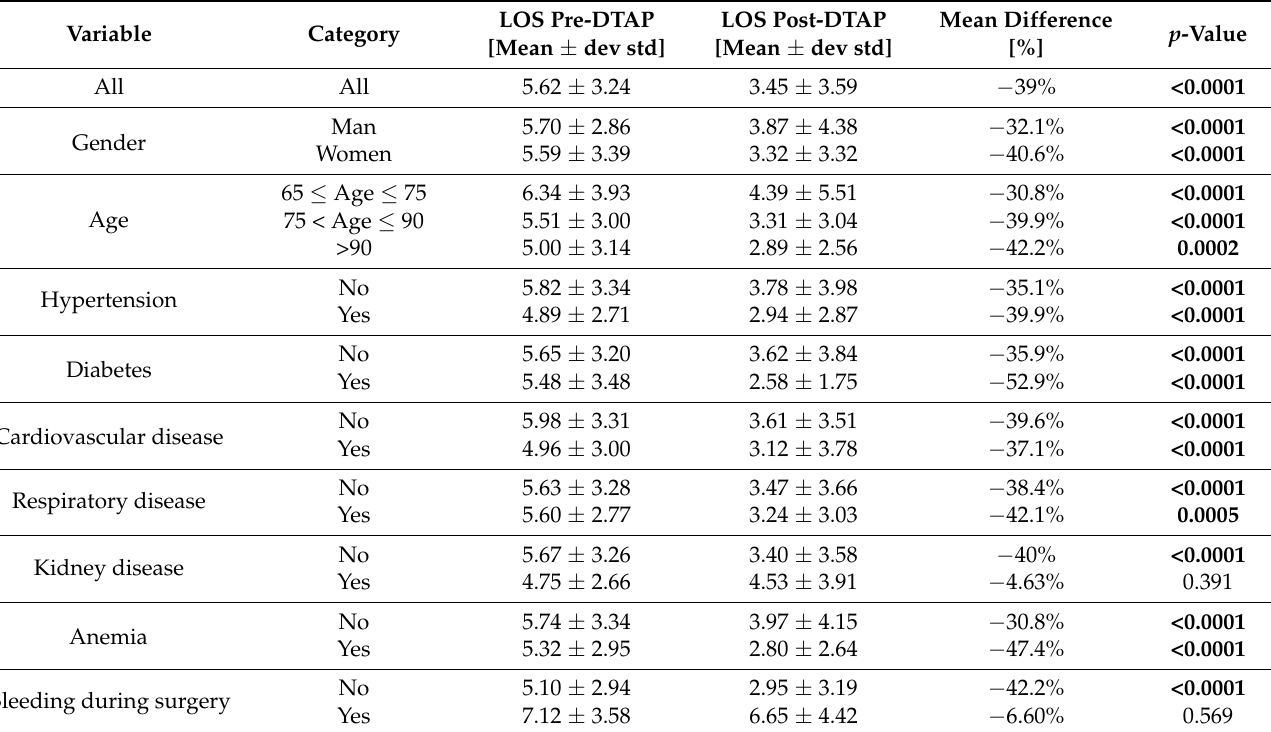
Table 3. Statistical analysis of preoperative LOS related to each variable and